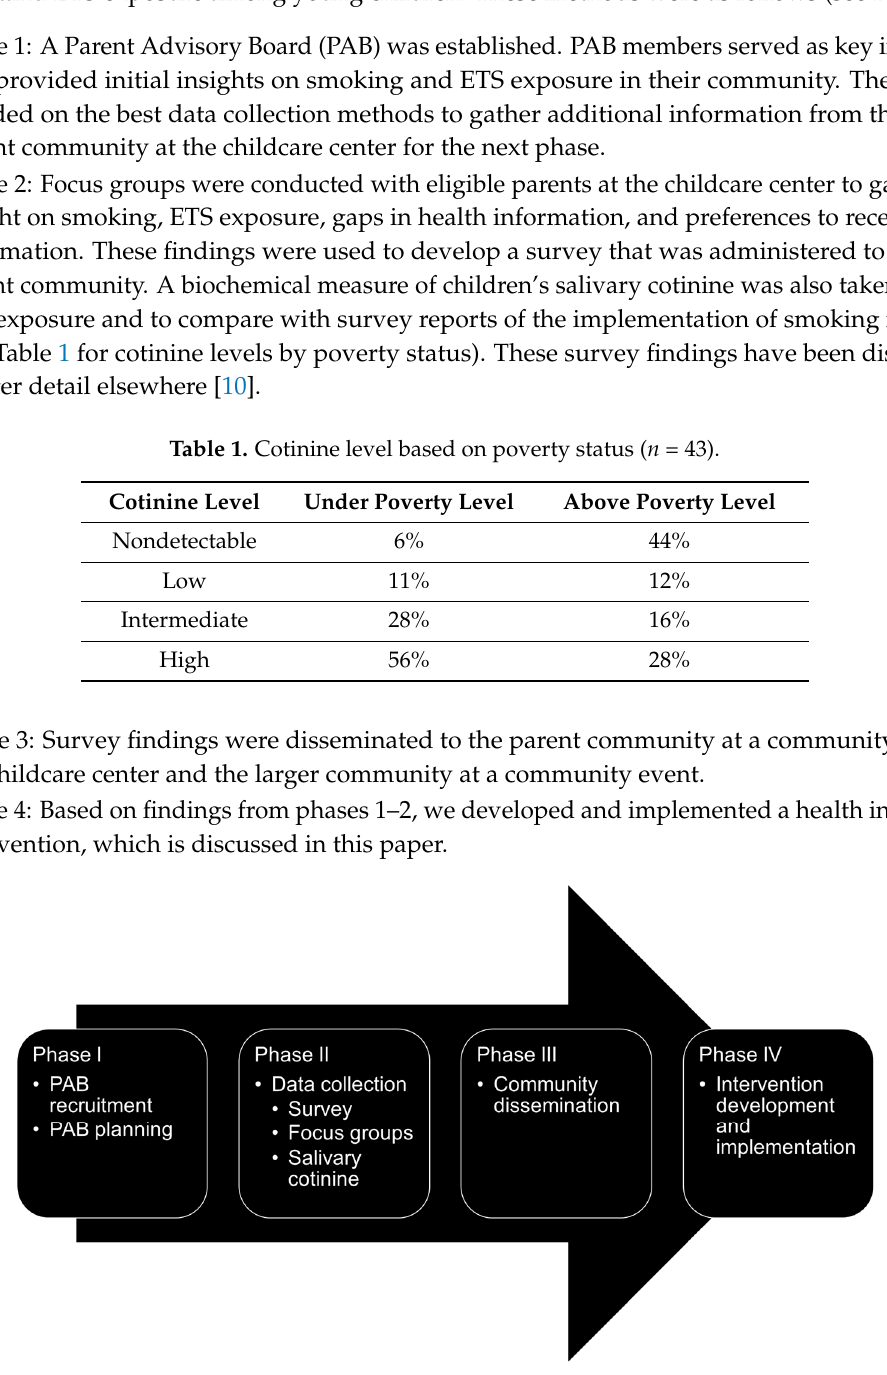
Figure 1. Formative research phases from Parent Advisory Board (PAB) recruitment to intervention development/implementation.